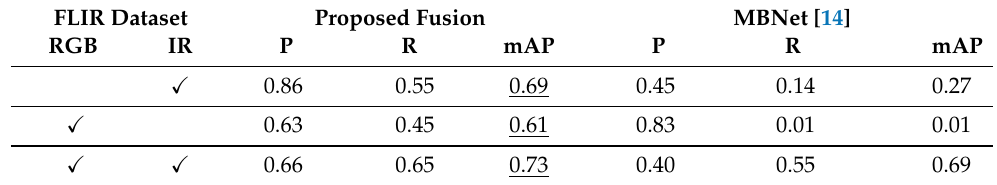
Table 4. Comparison of proposed fusion with the state-of-the-art method on aligned FLIR dataset. FLIR